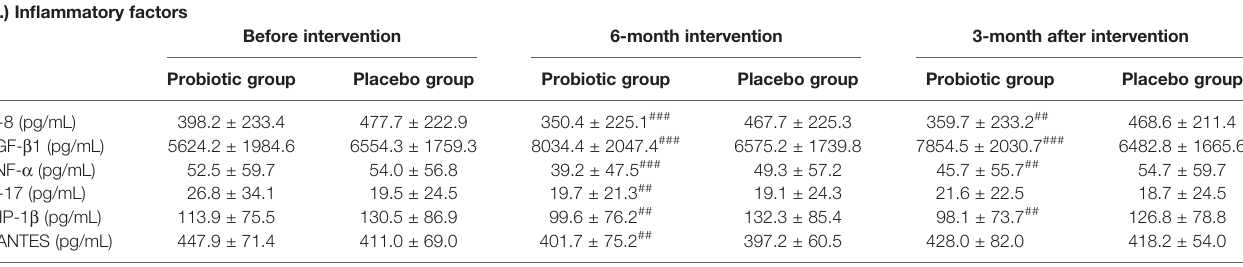
TABLE 3 | Analysis of in fl ammatory and anti-in fl ammatory cytokines after probiotic intervention. (a.) In fl ammatory